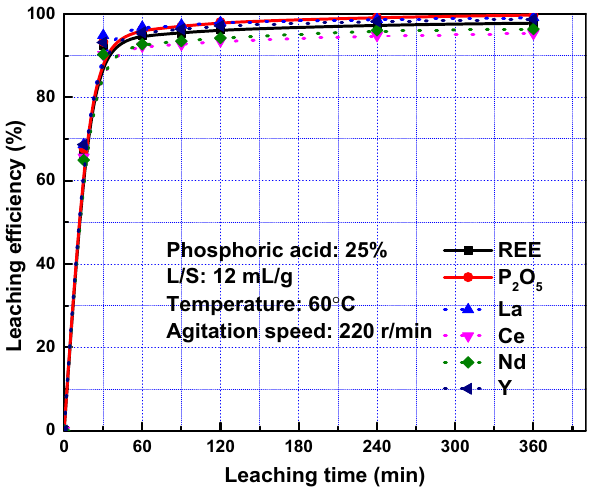
Figure 7: Leaching e ffi ciencies as a function of leaching